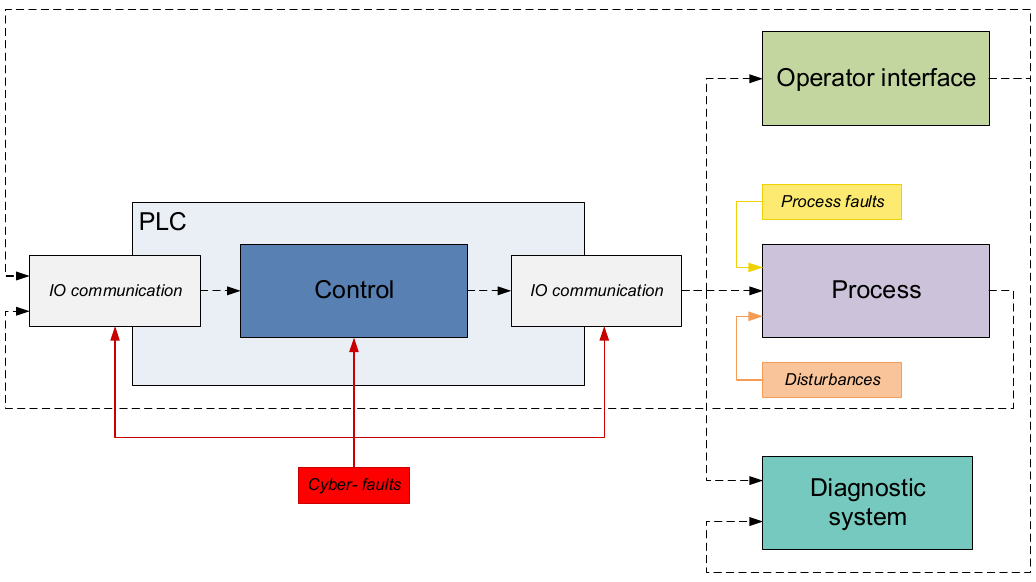
Figure 2. Block diagram of the simulator in the MATLAB/Simulink environment.